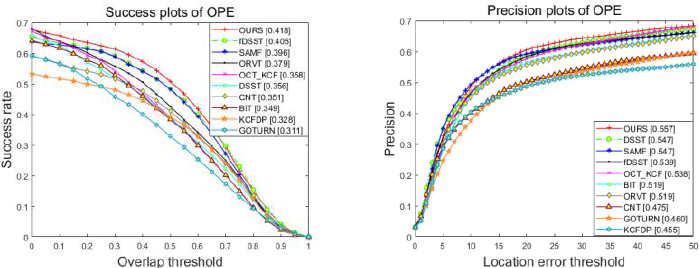
Figure 5. Success ( left ) and precision ( right ) plots of proposed tracker compared with state-of-the-art approaches on UAV123